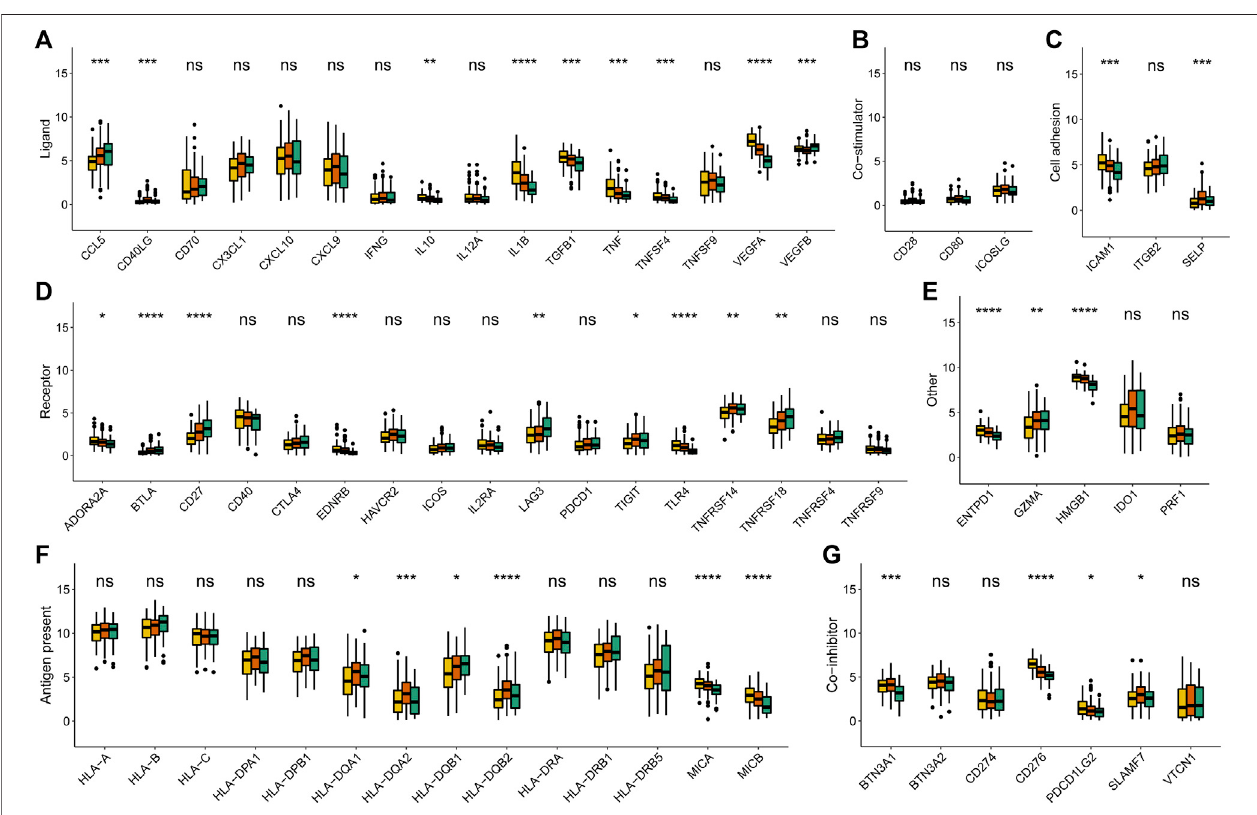
FIGURE 4| Immune checkpoints expression (normalized count) in each genecluster. The statistical differenceswere determined using the Kruskal – Wallis test and the statistical p value was represented by asterisks (ns represents no signi fi cance; * p < 0.05; ** p < 0.01; *** p < 0.001; **** p < 0.0001).